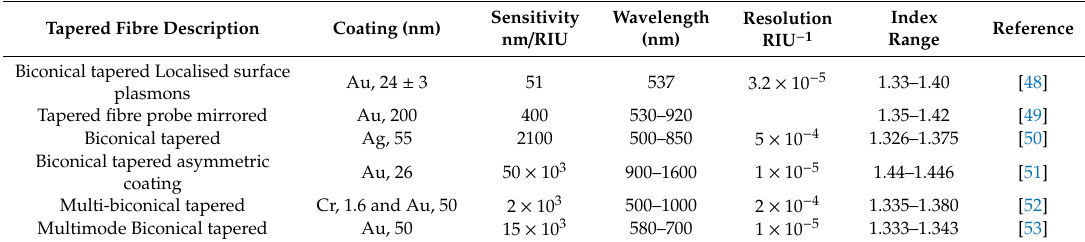
Figure 5. Typical Schematics of various fibre optical platforms used to produce surface plasmons. ( a ) Biconical tapered optical fibre surface plasmon resonance sensor. ( b ) Cladding removed fibre, the coating adhered directly to the core of the fibre. ( c ) An end-face reflection mirror / coating for the generation of the surface plasmons. ( d , e ) Conventional cylindrical optical fibre and D-shaped optical fibre, respectively, with a metal coating with the light coupled from a grating structure; tilted. ( f ) A low-dimensional nanostructured material / coating using a periodic strain field as the coupling mechanism for the light. ( g ) Photonic crystal fibre with the metal deposited on the inside of the holes of the fibre which support the surface plasmons. Table 1. Summary of various fibre tapered plasmonic